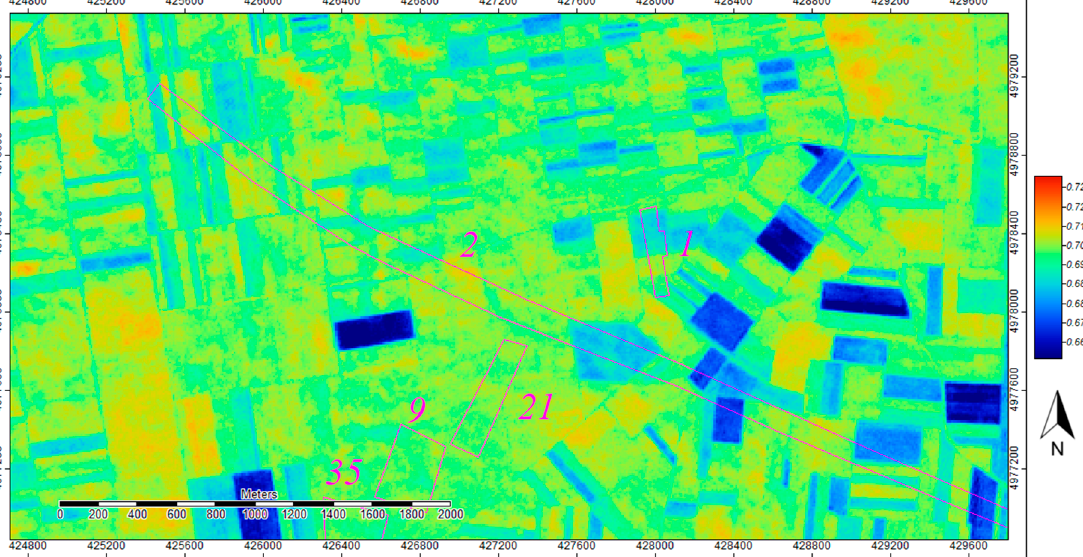
Figure 5. Output details of CC3 algorithm application to the Sentinel-2 image. The areas including the Roman road and other buried archaeological remains are marked in magenta, but it was not possible to detect them through this image. For a geographical reference, see the crop-marks identification numbers and locations in Figure 9.